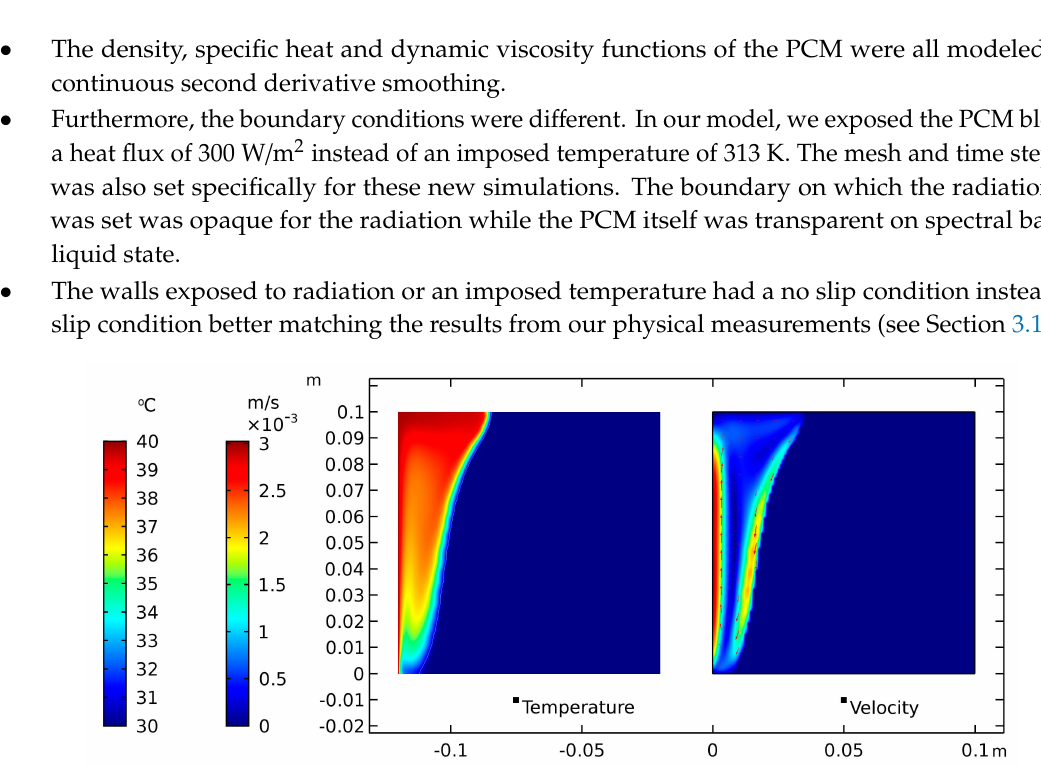
Figure 5. Results of the replication simulation of the model by Murray and Groulx [21] after t = 5000